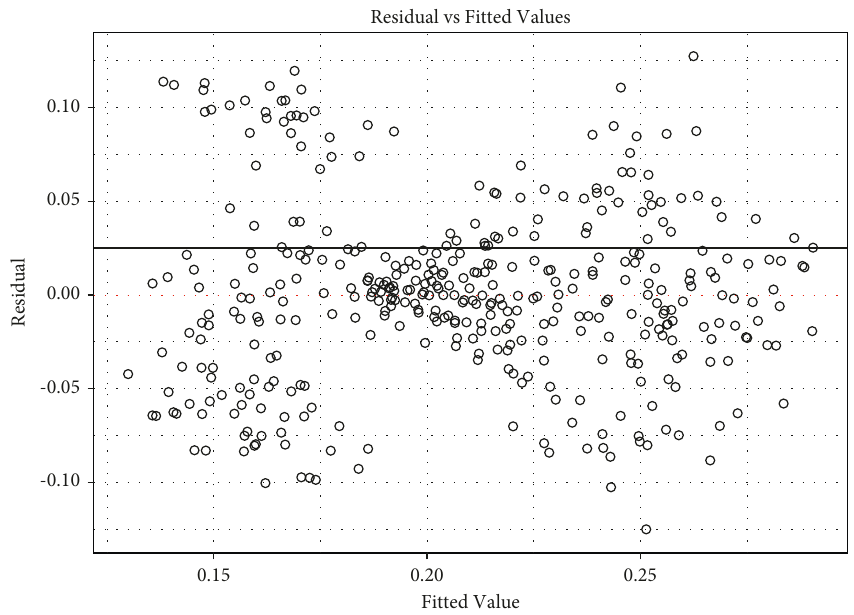
Figure 3: Residuals versus fitted values plot for initial model.